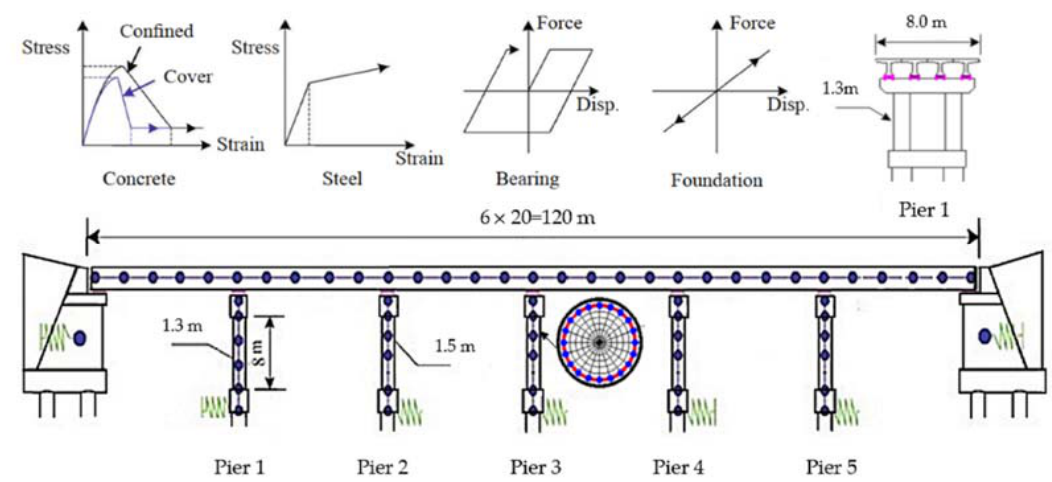
Figure 2. The isolated girder bridge structural configuration.